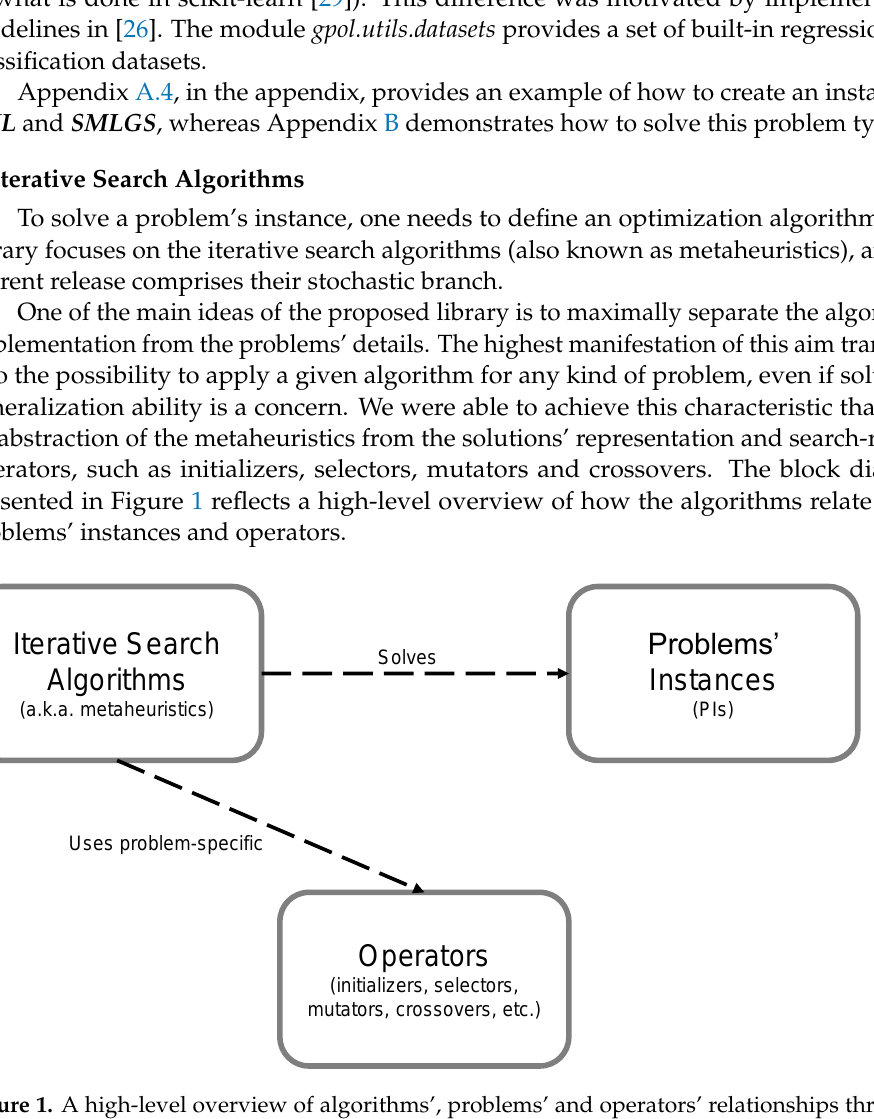
Figure 1. A high-level overview of algorithms’, problems’ and operators’ relationships through a